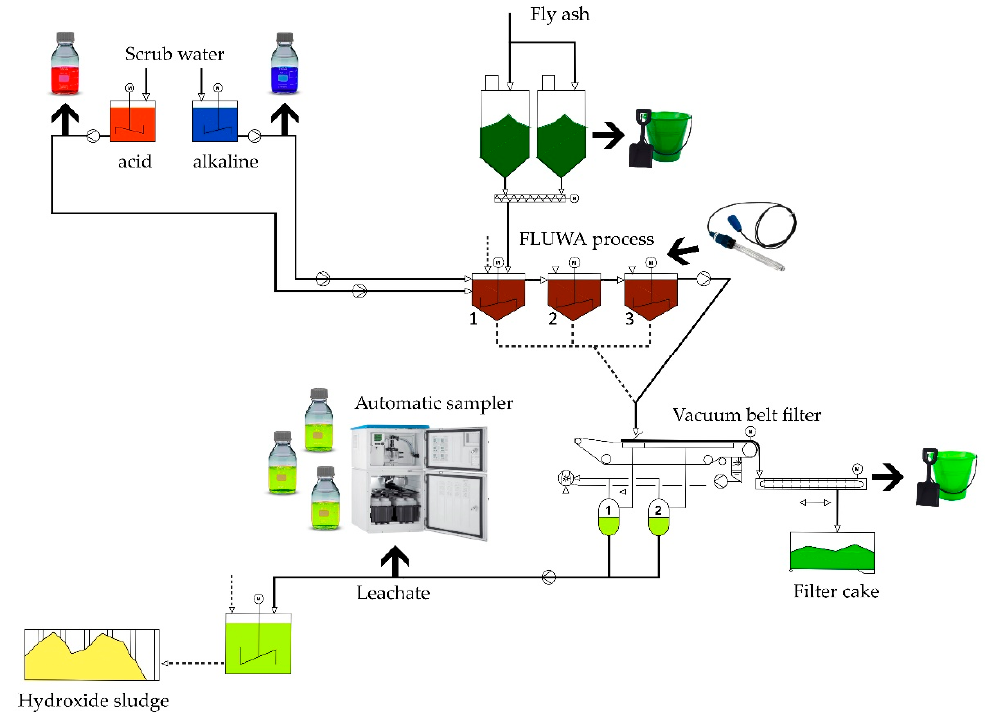
Figure 1. Scheme of the acid fly ash leaching (FLUWA) process and sampling locations during the industrial-scale experiments.